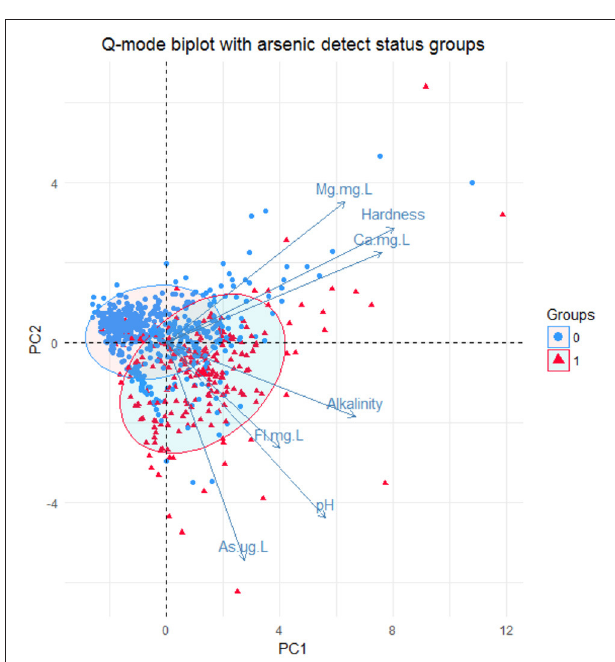
FIGURE 6 | Q-mode PCA analysis biplot of the 1st two principal components. Ellipses were drawn around the points from each detect group encompassing 68% of the points in each group with each ellipse. Group = 0 = no detect, Group = 1 = detect.